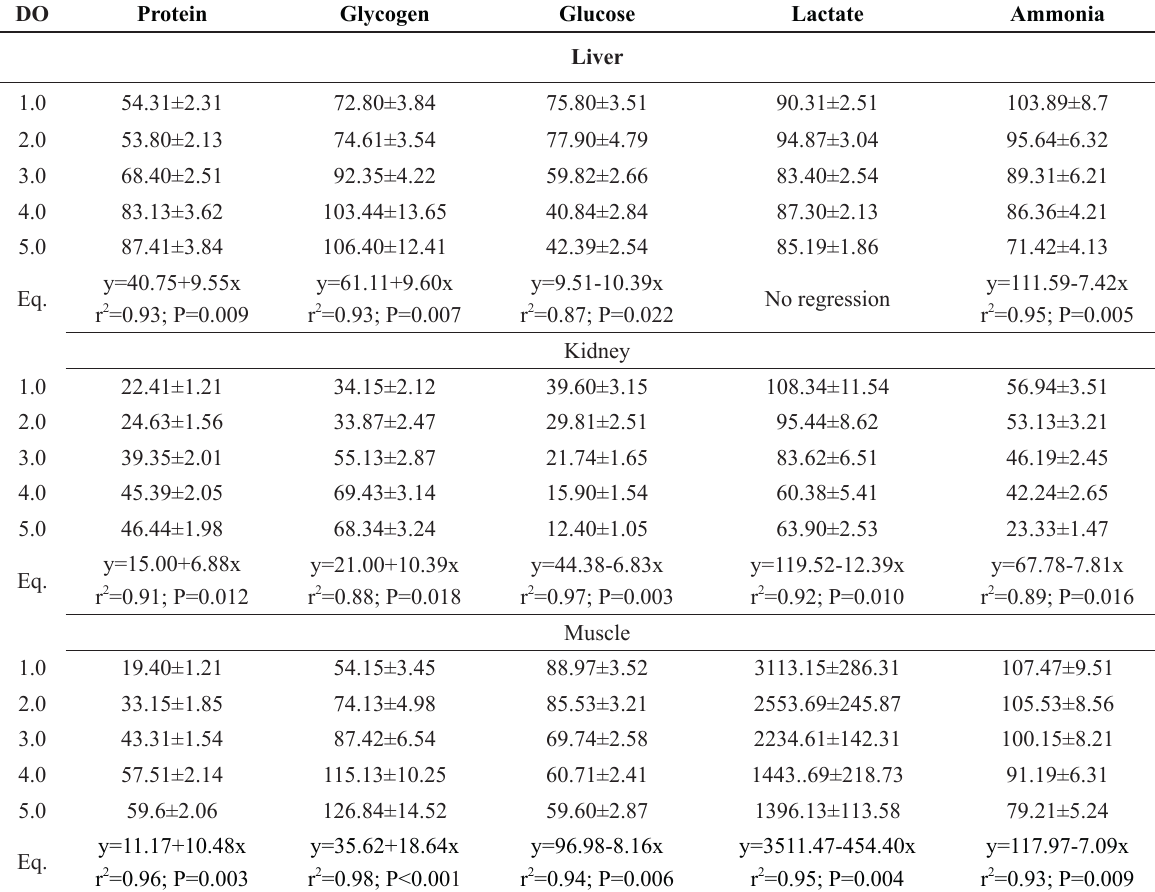
Effects of different dissolved oxygen (DO) levels (mg L -1 ) on biochemical variables in tissues of piava juveniles. DO Protein Glycogen